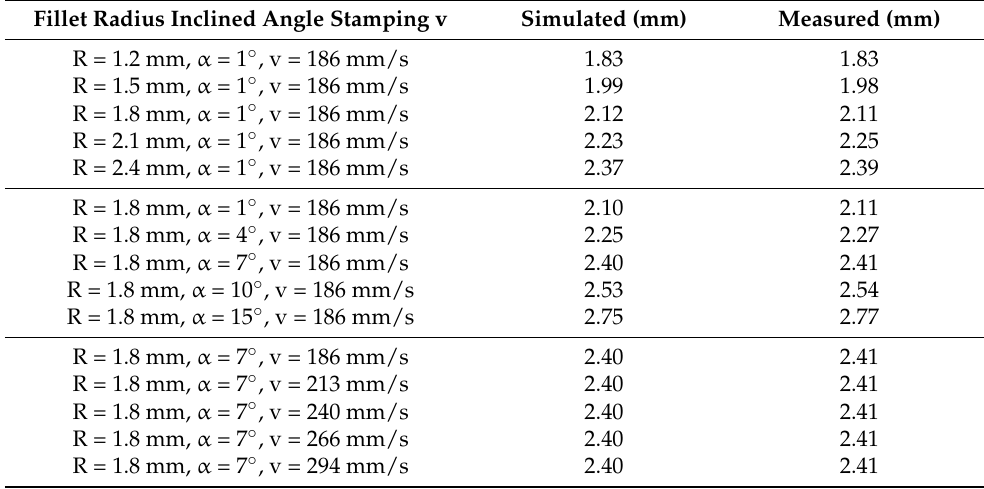
Table 3. Simulated nosing dimension vs. measured nosing dimension. Fillet Radius Inclined Angle Stamping v Simulated (mm) Measured